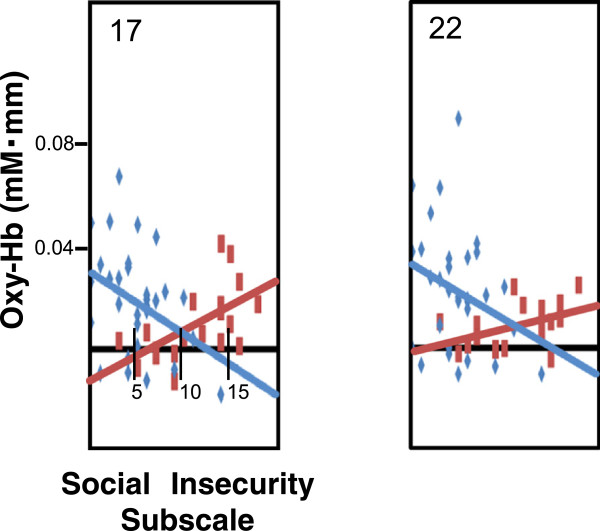
Enlarged graphs for channels 17 and 22.